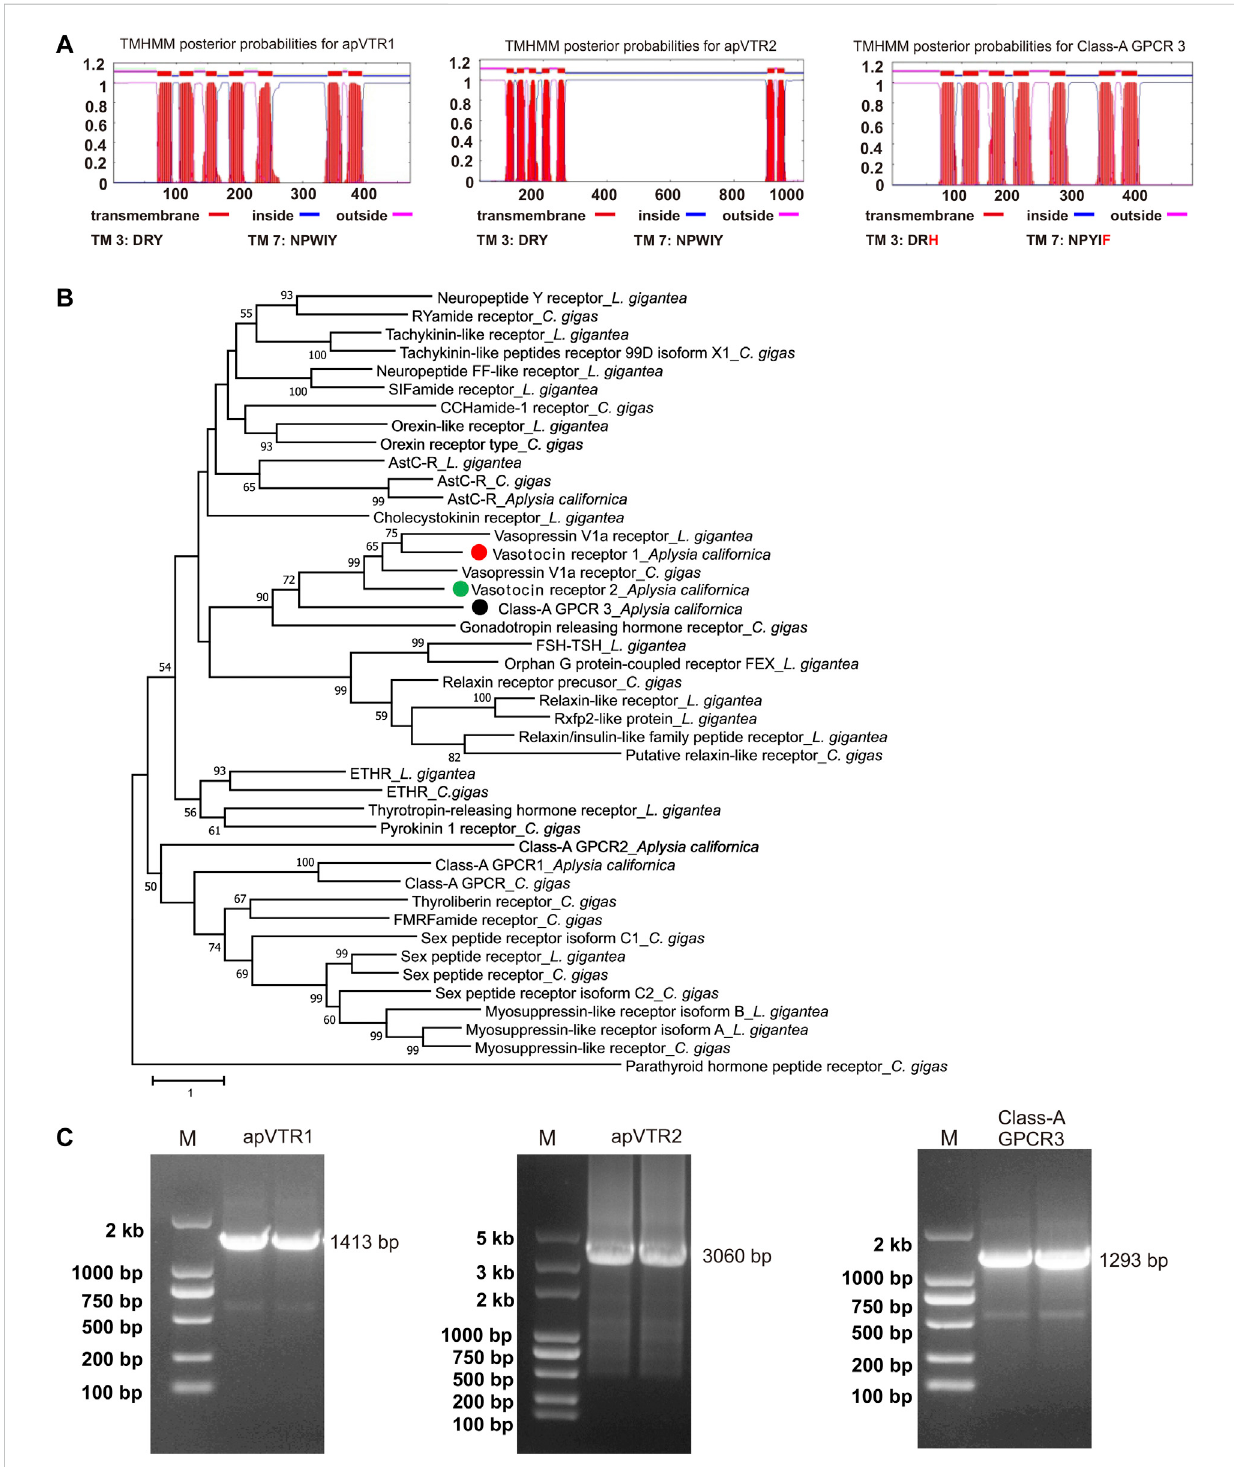
Cloning and bioinformatics of Aplysia putative vasotocin receptors (apVTRs). (A) Prediction of 7TM of putative receptors (left to right): apVTR1, apVTR2, and Class-A GPCR 3 using TMHMM. Conserved motifs in transmembrane domain 3 (TM3: D/ERY) and TM7 (NPXXY) are shown below. Residues different from conserved motifs are shown in red. (B) . A phylogenetic tree of three Aplysia putative receptors (apVTR1, apVTR2, Class-A GPCR 3) with a number of molluscan sequences from Jiang et al., 2022 (see the Results and Supplementary Table S3) using MEGA X (see the bioinformatic section of the Methods for more details). A Class-B G protein-coupled receptor: Parathyroid hormone peptide receptor_ C.gigas , was used as an outgroup. The tree suggests that the threesequences could potentiallybe vasotocin receptorsas they areclusteredtogether with otherputative vasotocin/vasopressin receptors.Thetreeisdrawntoscale,withbranchlengthsmeasuredinthenumberofsubstitutionspersite.Numbers atthenodesarebootstrap valuesas a percentage. Only bootstrap values greater than 50 are shown. (C) The PCR products of three putative vasotocin receptors (left to right): vasotocin receptor 1 (apVTR1) with a length of 1,413 bp, vasotocin receptor 2 (apVTR2) with a length of 3,060 bp, Class-A GPCR 3 with a length of 1,293